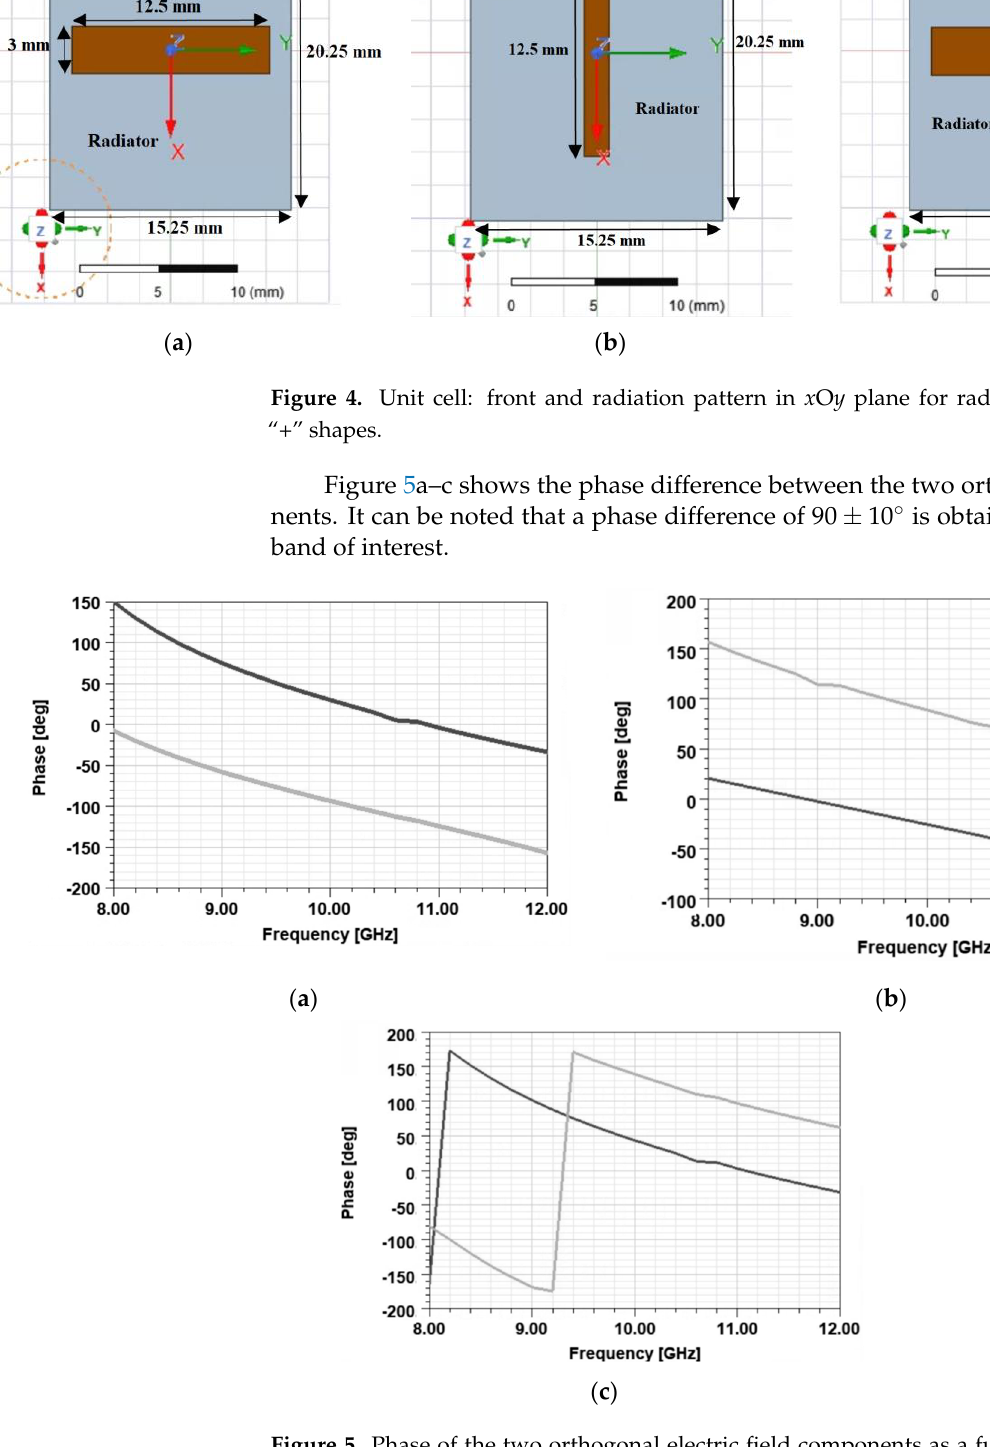
Figure 5. Phase of the two orthogonal electric field components as a function of frequency (grey line— y component; black line— x component).